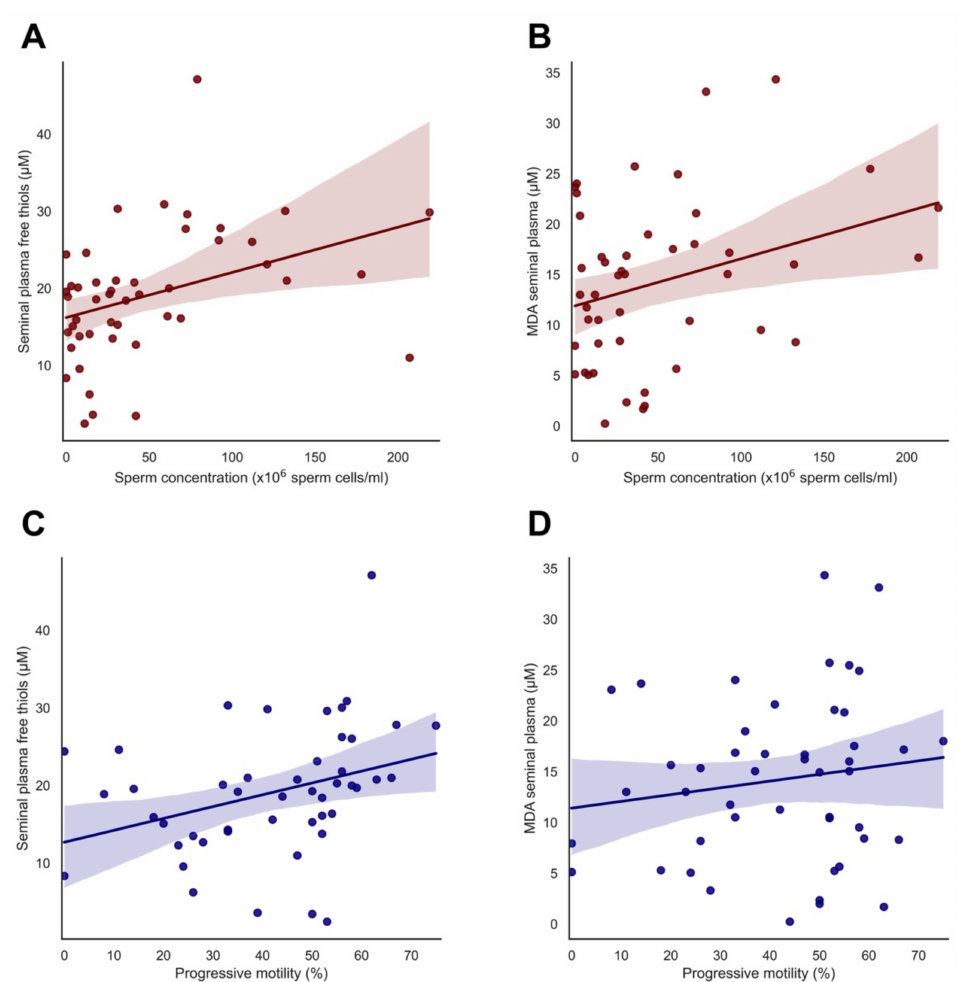
Figure 1. Association between seminal plasma-free thiols, seminal plasma MDA and sperm parame- ters: ( A ) Significant positive correlation between seminal plasma-free thiols and sperm concentration (r = 0.383, p = 0.008); ( B ) Significant positive correlation between seminal plasma MDA and sperm concentration (r = 0.314, p = 0.031); ( C ) Significant positive correlation between seminal plasma-free thiols and progressive motility (r = 0.333, p = 0.022); ( D ) No significant correlation between MDA seminal plasma and progressive motility (r = 0.150, p = 0.316). Lines represent best fitting lines from linear regression. Color-shaded areas indicate 95% confidence